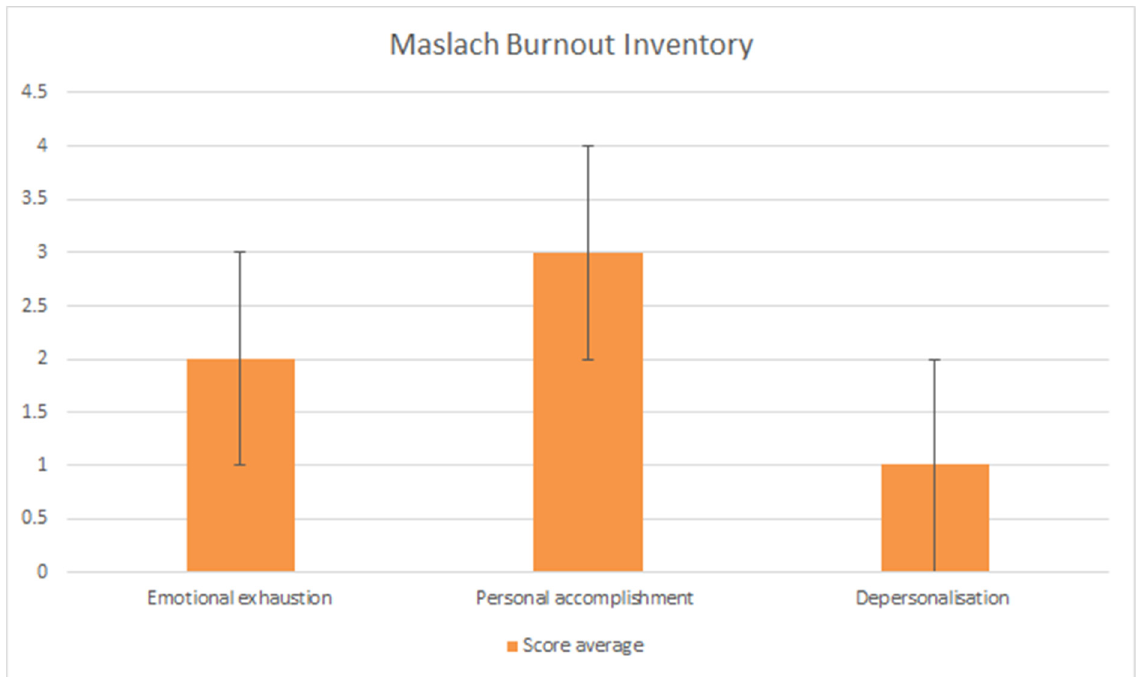
Scheme 1. Graphic representation of the mean of the three Maslach Burnout Inventory results with standard deviation.